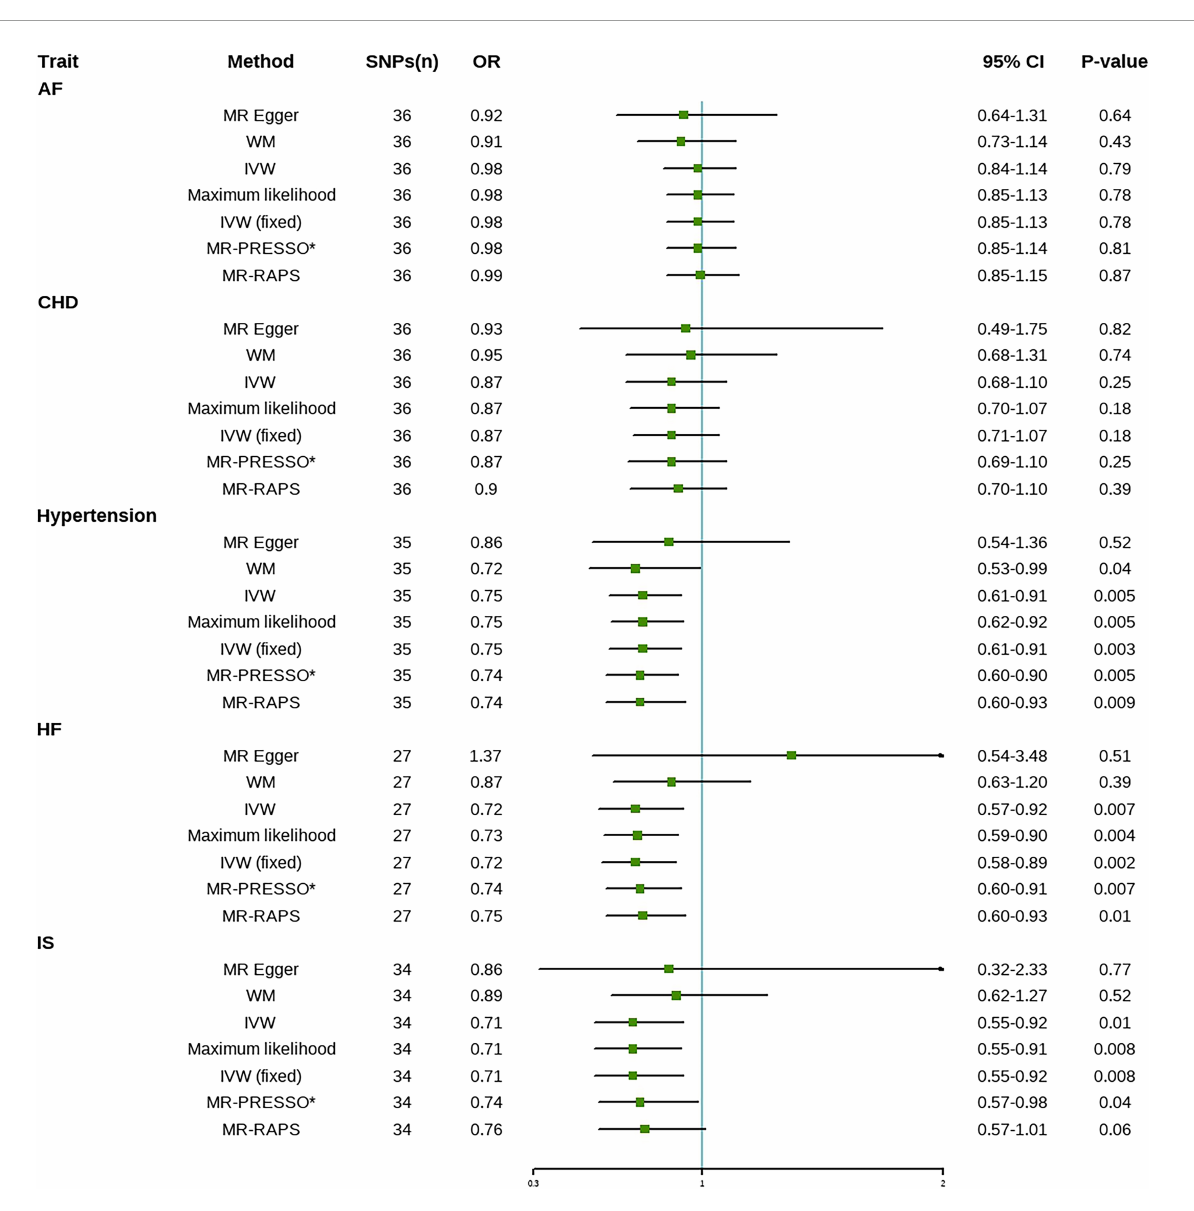
FIGURE3 Mendelian randomization estimates of tea intake on the risk for CVD. AF, atrial fibrillation; CHD, coronary heart disease; HF, heart failure; IS, ischemic stroke; SNPs, Single nucleotide polymorphisms; OR, Odds ratio; CI, Confidence interval; IVW, inverse-variance weighted; IVW (fixed), fixed-effects inverse-variance weighted; MR-RAPS, MR-robust adjusted profile score; MR-PRESSO, MR-pleiotropy residual sum and outlier; *No outlier was